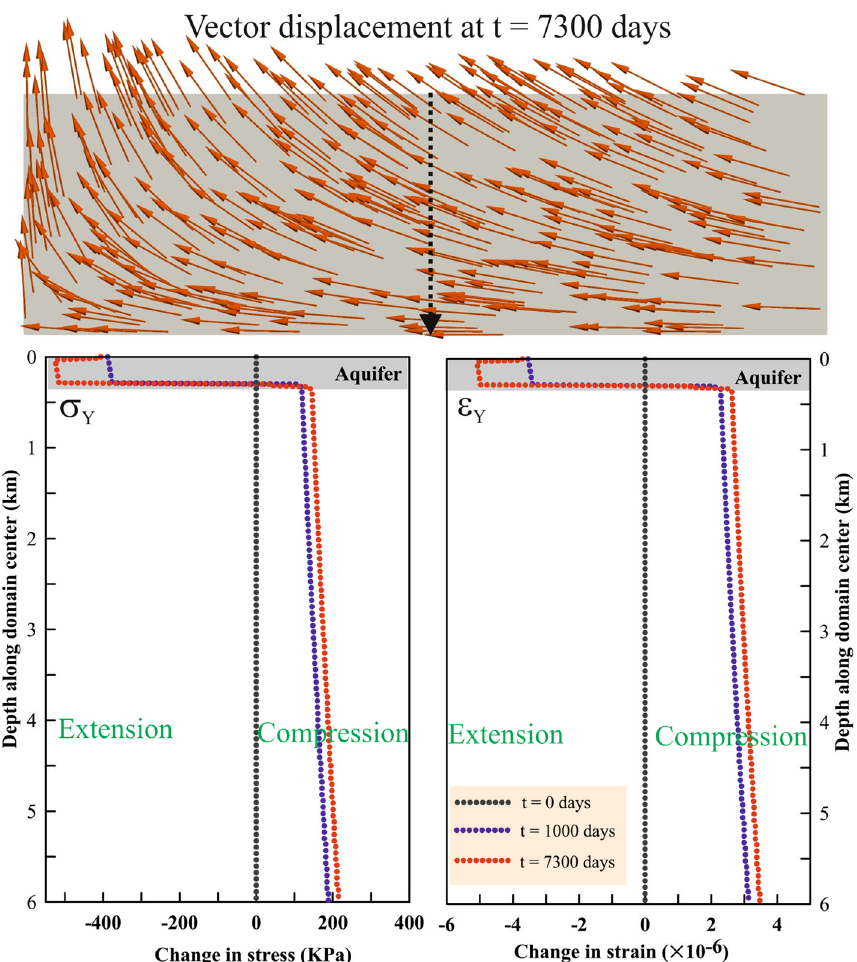
Figure 5. Aquifer contraction and basement rock expansion. Topmost panel shows the simulated displacement vector field after 20 years (i.e., 7300 days) of groundwater extraction from the aquifer. Its effect on aquifer contraction and basement rock expansion is shown by the corresponding stress and strain changes, which are plotted with depth along the domain center at different time steps in the lower two panes. This figure was generated using Grapher graphical application (version 8.7.844 URL: https:// www. golde nsoft ware. com/ produ cts/ graph er) and ParaView application (version 5.7.0 URL: https:// www. parav iew.